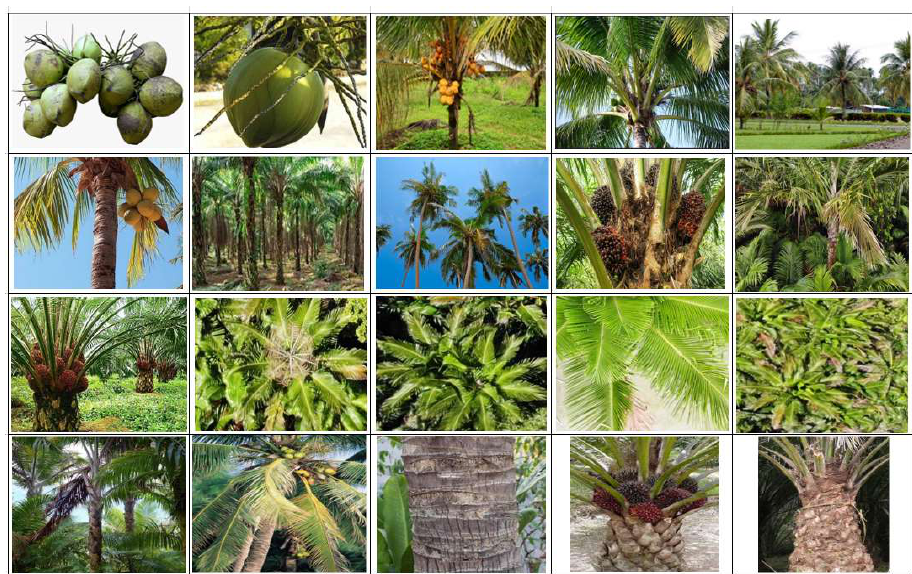
Figure A3. Sample dataset: testing data.